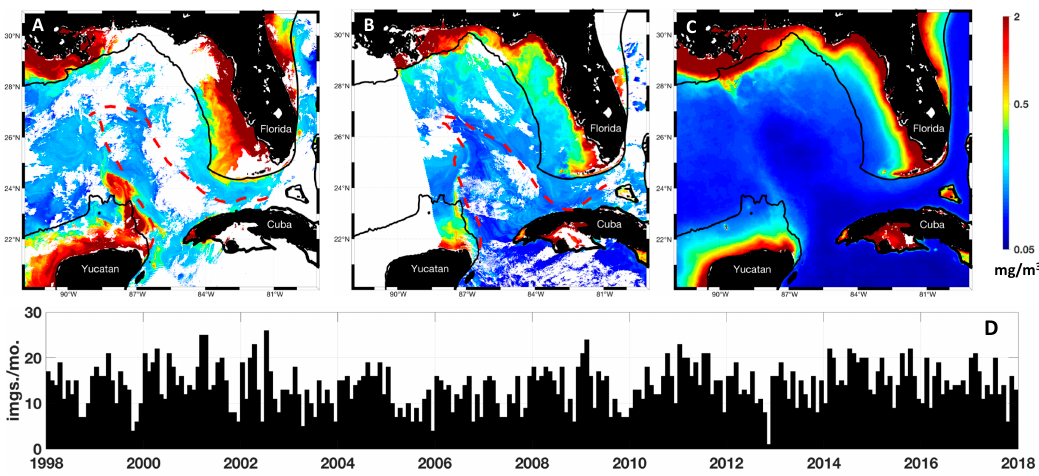
Figure 2. MODIS-Aqua chlorophyll-a images showing transport of water from the Campeche Bank into the central Gulf of Mexico. From left, images are from ( A ) 27 October 2005, ( B ) 30 March 2008, and ( C ) May climatology from 2003 to 2018. ( D ) Time series of the number of images per month which showed evidence of transport from Campeche Bank to the central Gulf of Mexico. Solid black line represents the 100 m isobath. Dashed red line in panels A and B represents the contour of the Loop Current estimated from altimetry derived MADT data for the date of the corresponding satellite image.